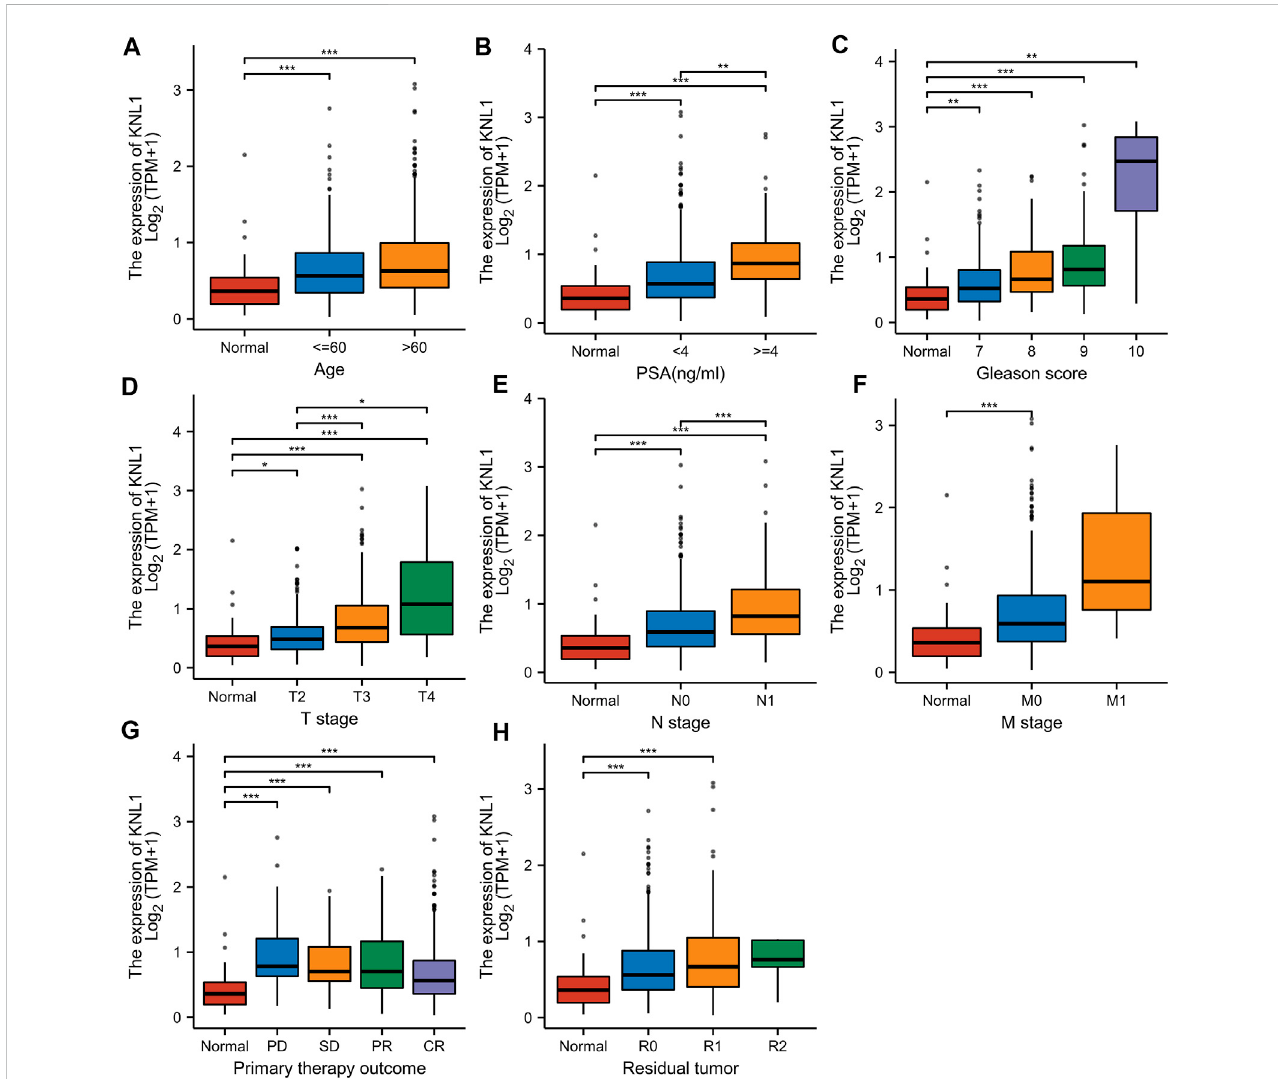
FIGURE 2 AssociationsbetweenKNL1 expression and differentclinical characteristics inPRAD. (A) Age; (B) PSA (ng/ml); (C) Gleason score; (D) T stage; (E) N grade; (F) M grade. (G) Primary therapy outcome; (H) Residual tumor (* p < .05, ** p < .01, *** p < .001).